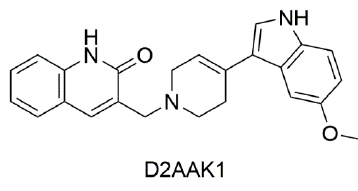
Figure 1. 2D structure of D2AAK1.